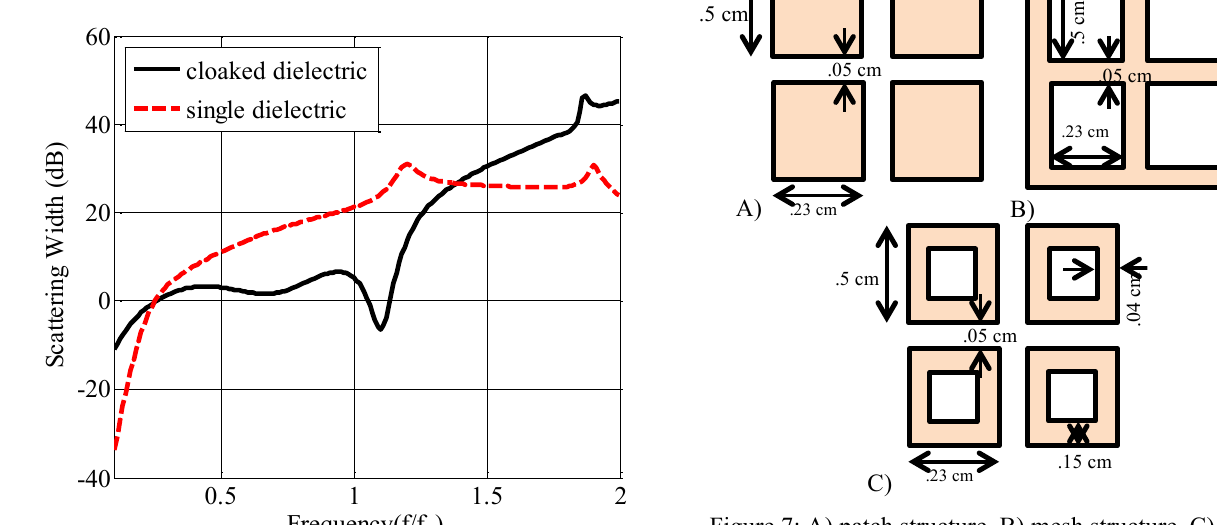
Figure 7: A) patch structure. B) mesh structure. C) ring